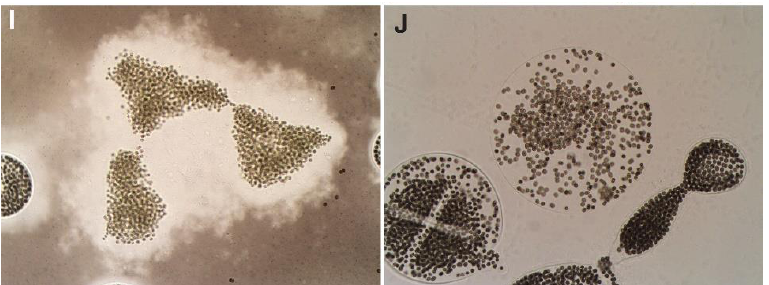
Figure 4. Microcystis colonies 72 h post-treatment with copper-based algaecides. Algimycin ® PWF: